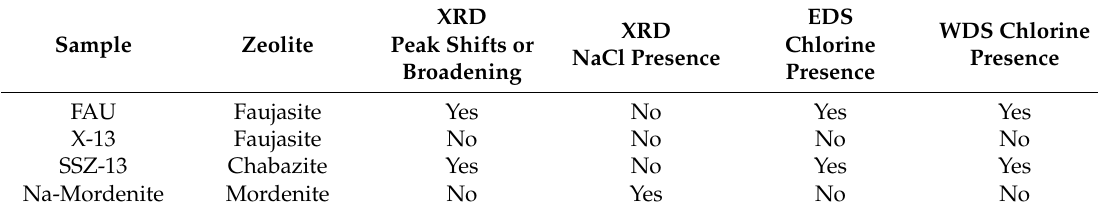
Table 1. Summary of evidence indicating the chloride-bearing potential of